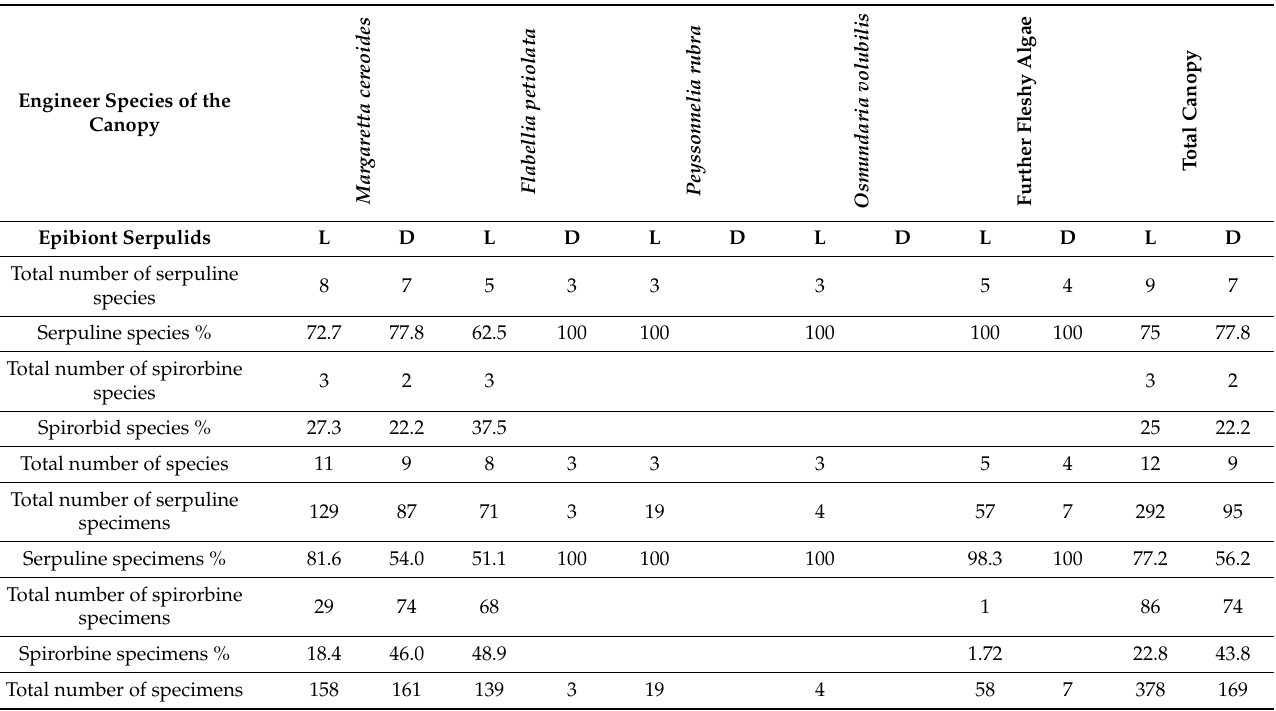
Table 4. Relevance (numbers and relative percentages) of the two serpulid subfamilies in the epibiont assemblages found on the bryozoan Margaretta cereoides and main algae of the canopy of the build-up E collected offshore of Marzamemi (Ionian Sea). L: living and D: dead